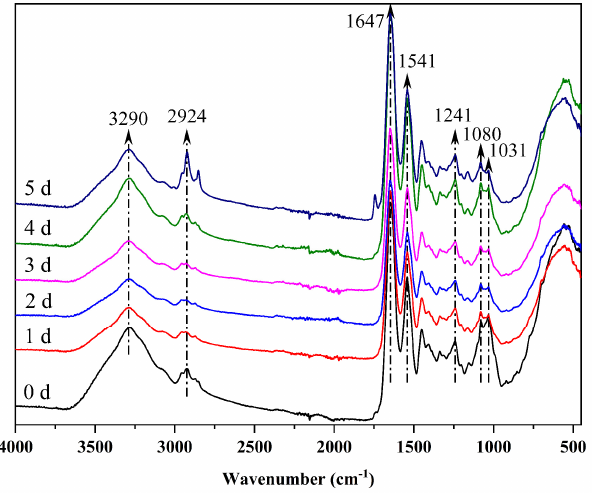
Figure 5. FTIR spectra of gelatin/zein/glucose nanofibers after Maillard reactions conducted at 60 °C and 50% RH for 0~5 days. Table 1. The relative absorbance of FTIR spectra of gelatin/zein/glucose nanofibers after Maillard reactions conducted at 60 °C and 50% RH for 0~5 days. Wavenumber/cm −